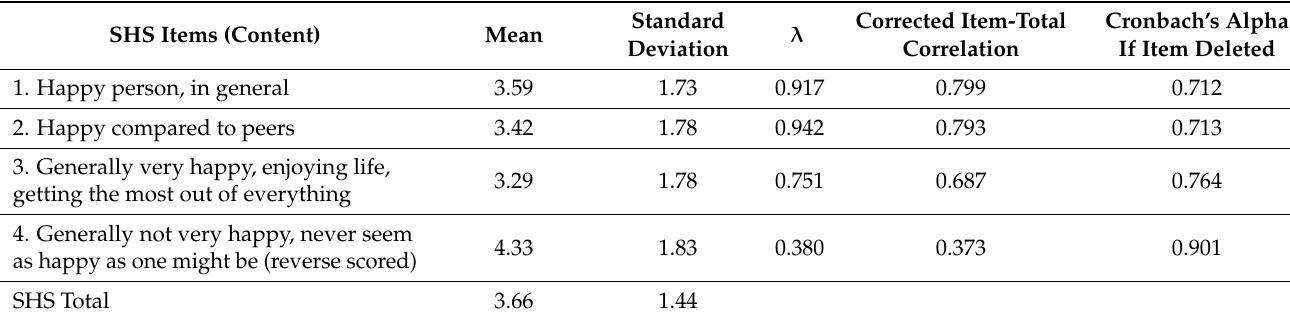
Table 1. Means, standard deviations, standardized factor loadings ( λ ), corrected item-total correlations and Cronbach’s alphas if item deleted for the SHS ( n = 174).